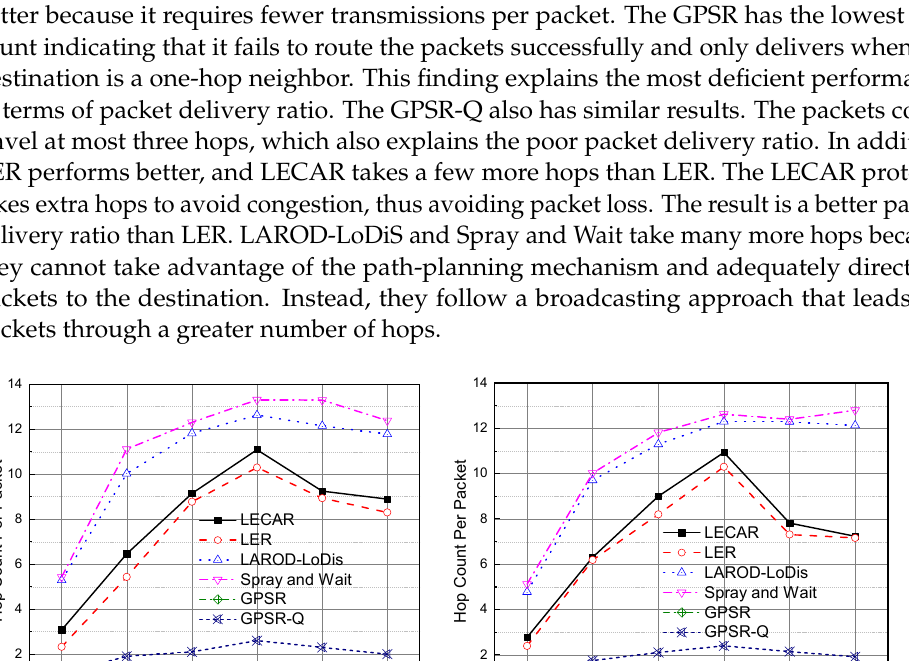
Figure 13. Performance comparison of the routing protocols regarding the number of copies per packet when the buffer size is ( a ) 25 MB and ( b ) 50 MB.